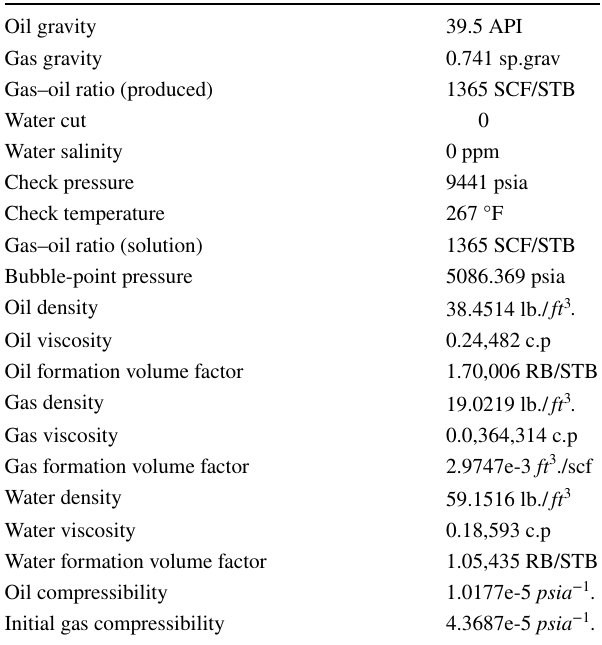
Table 3 Properties of equipment in perforation